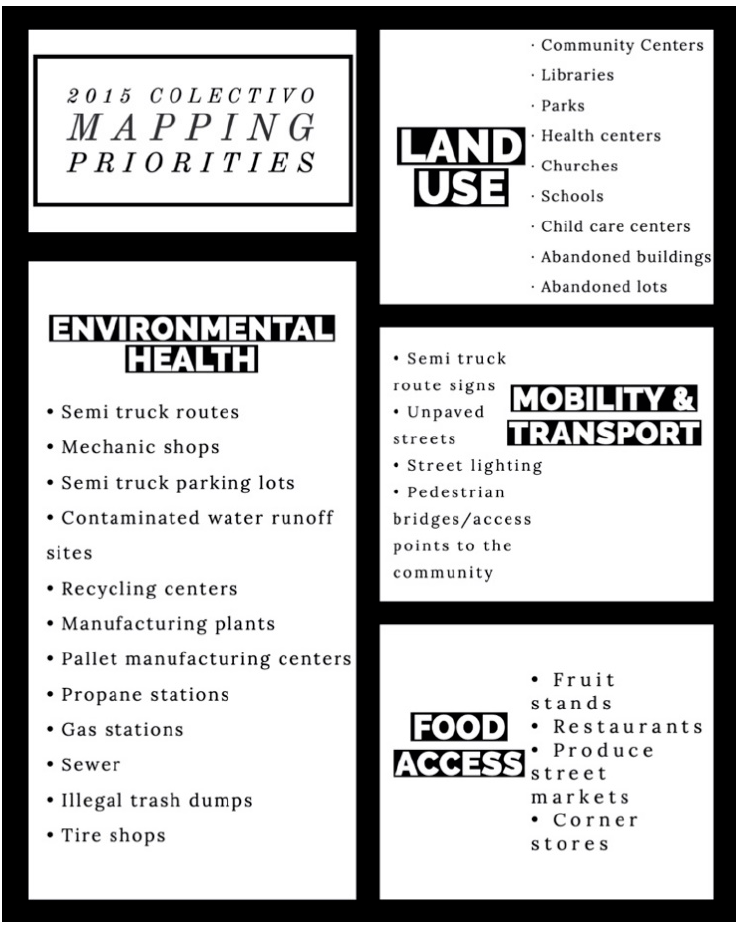
Figure 3. 2015 Colectivo mapping priorities.